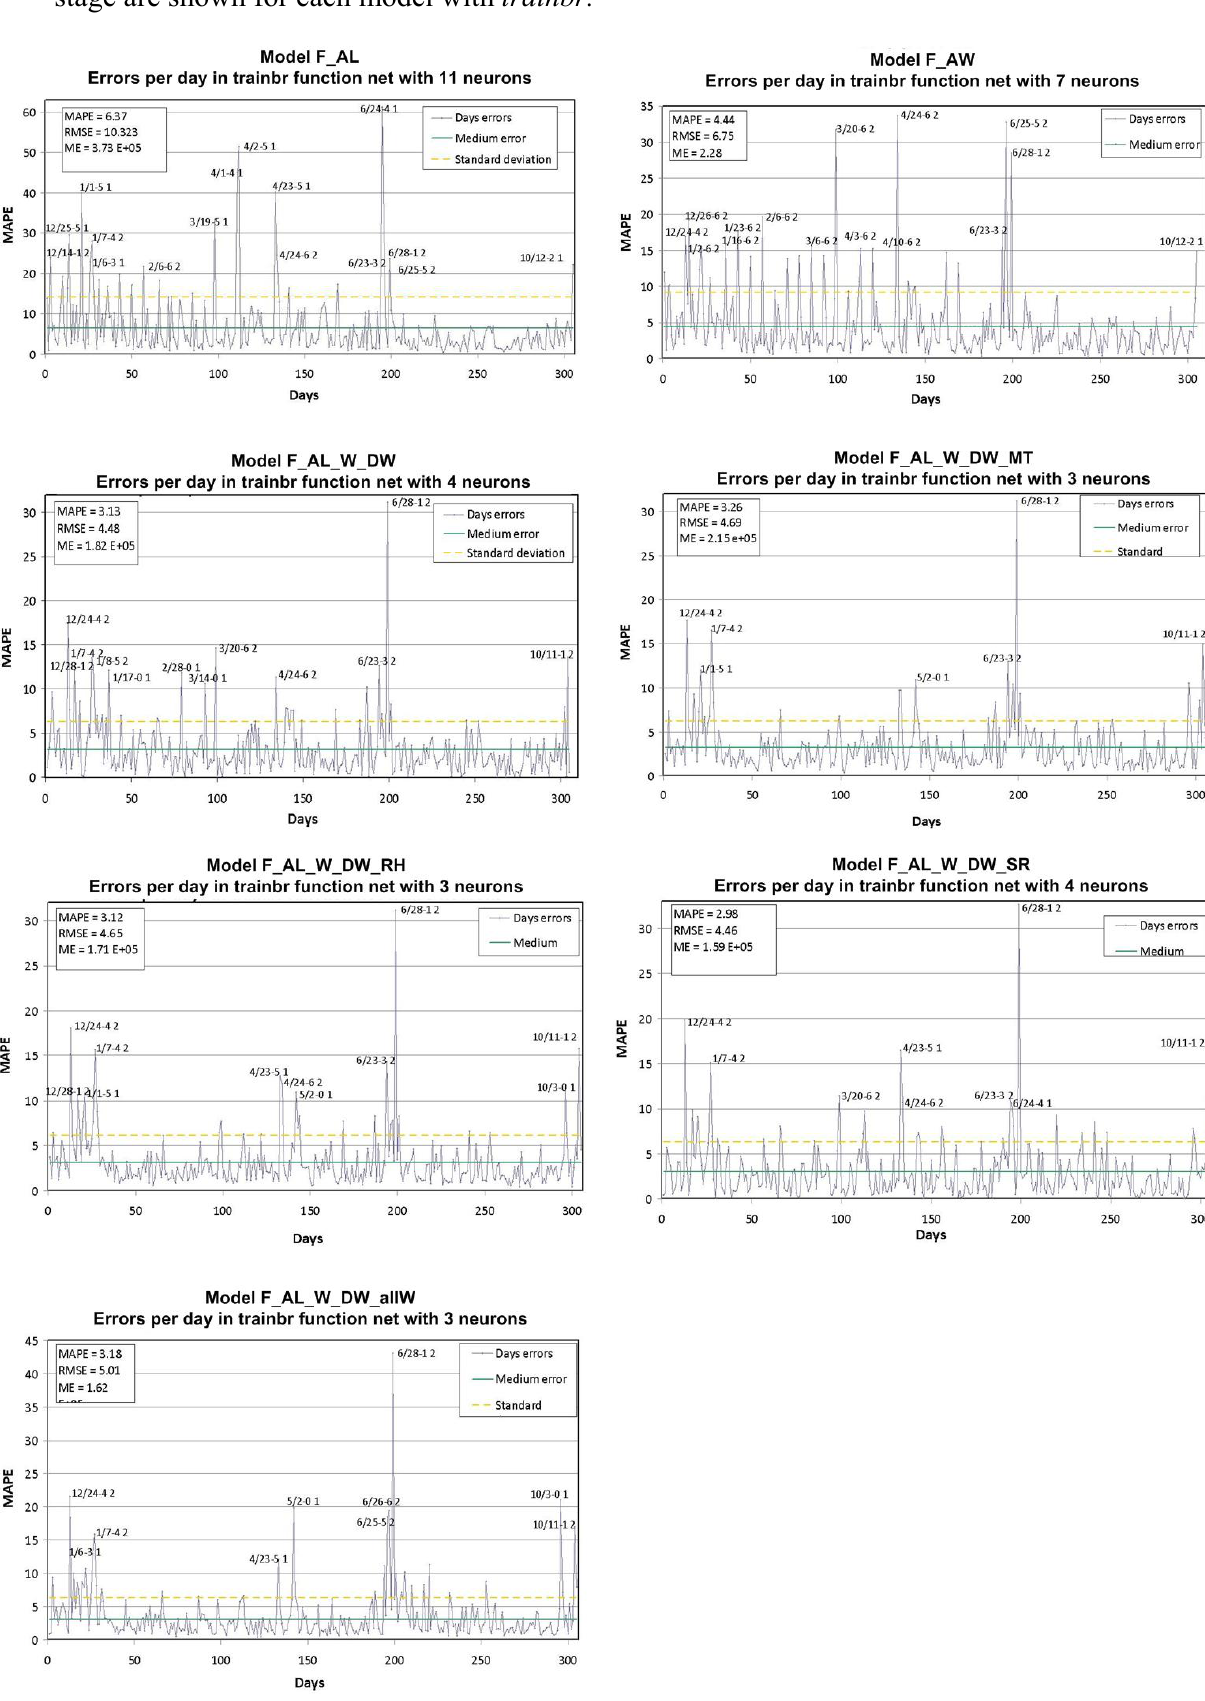
Figure 6. The MAPE (%), RMSE (dimensionless) and ME (W) values of the operation stage are shown for each model with